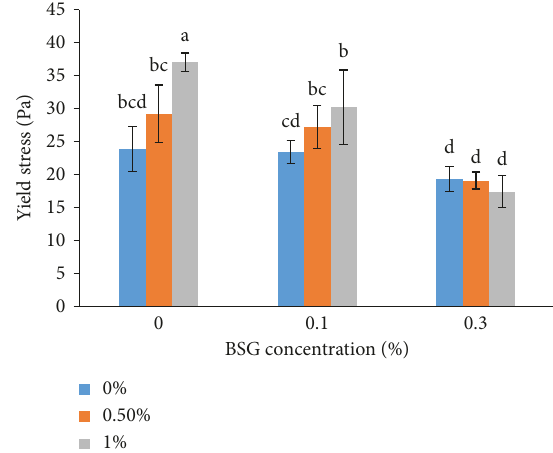
Figure 5: Effect of NaCl and basil seed gum concentration on yield stress in the foams made of egg albumin in the absence and presence of basil seed gum. Columns with different letters are significantly ( p < 0 . 05)